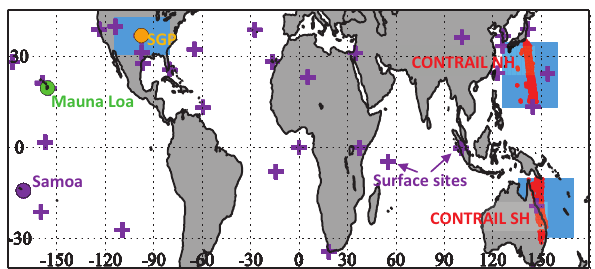
Fig. 3. Validation locations: In the Northern Hemisphere, CON- TRAIL data (red dots, 13 ◦ –35 ◦ N, ∼ 140 ◦ E, 10–11km) are com- pared to TES in the same vicinity (blue, 13 ◦ –35 ◦ N, 128 ◦ –158 ◦ E). The same TES data are compared to Mauna Loa observatory (green, 19.5 ◦ N, 155 ◦ W at 3.4km). Over land, TES (28.8 ◦ –44.8 ◦ N, 109.8 ◦ –85.5 ◦ W) is compared to aircraft data at the Southern Great Plains (SGP) ARM site in the US (orange, 36.8 ◦ N, − 97.5 ◦ W, 0.5– 5.3km). In the Southern Hemisphere CONTRAIL data (red dots, 10 ◦ –30 ◦ S, ∼ 150 ◦ E, 10–11km) are compared to TES data from the box (10 ◦ –30 ◦ S, 128 ◦ –168 ◦ E). These are also compared to the Samoa surface site (purple circle, 14 ◦ S, 170 ◦ W). TES data be- tween 40 ◦ S and 45 ◦ N are also compared to the GLOBALVIEW dataset (purple